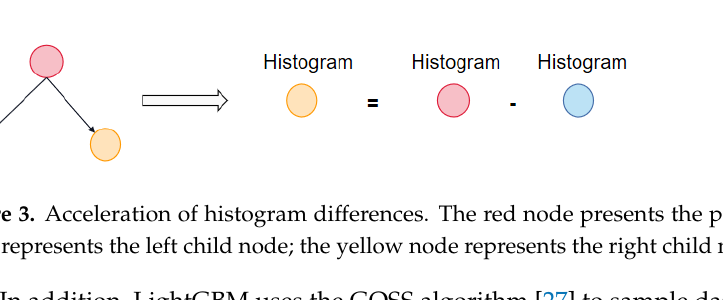
Figure 2. Levelwise and leafwise. Red nodes represent nodes that have been split, and the blue nodes represent the node to be split.